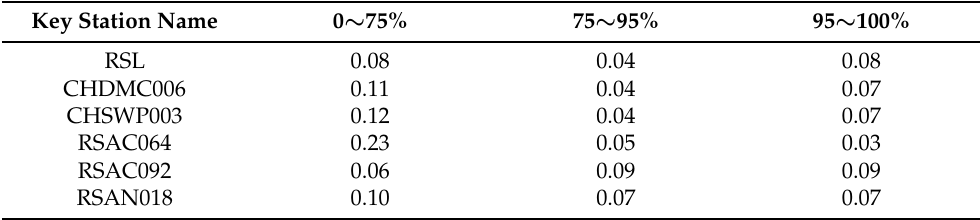
Table A5. Standard deviation of target ( σ ref ) for six key stations. S t to Equation (2).